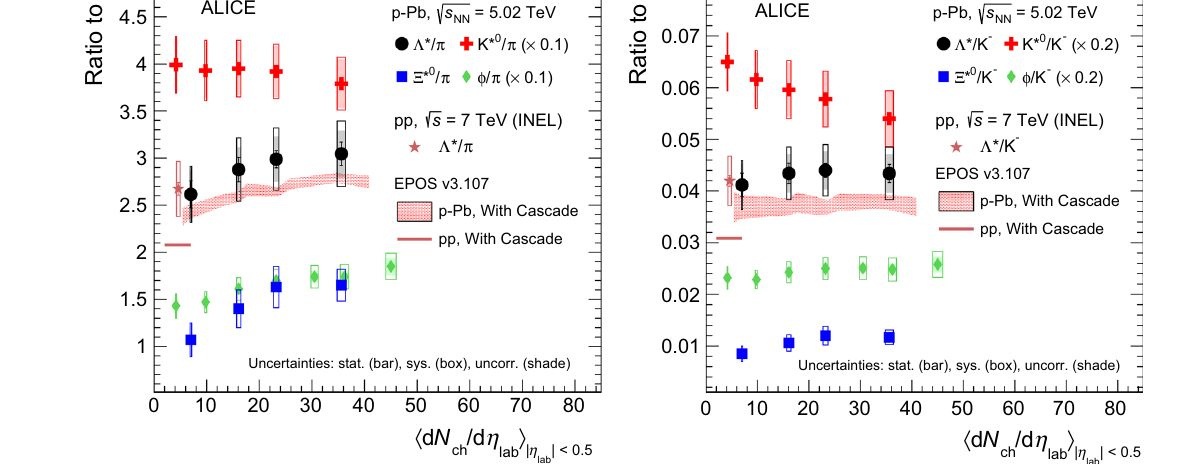
Uncertainties: stat. (bar), syst. (box), uncorr. (shaded box)